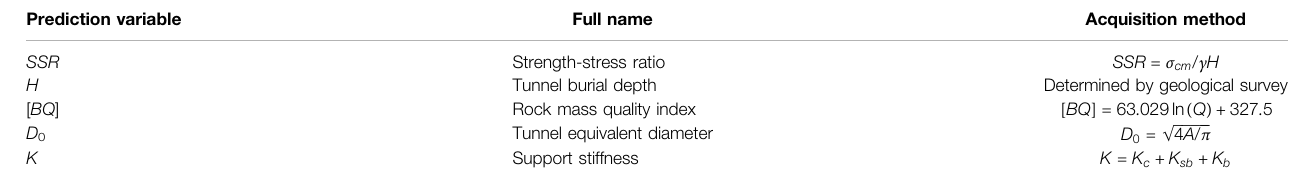
TABLE 1 | The acquisition methods of fi ve prediction variables.